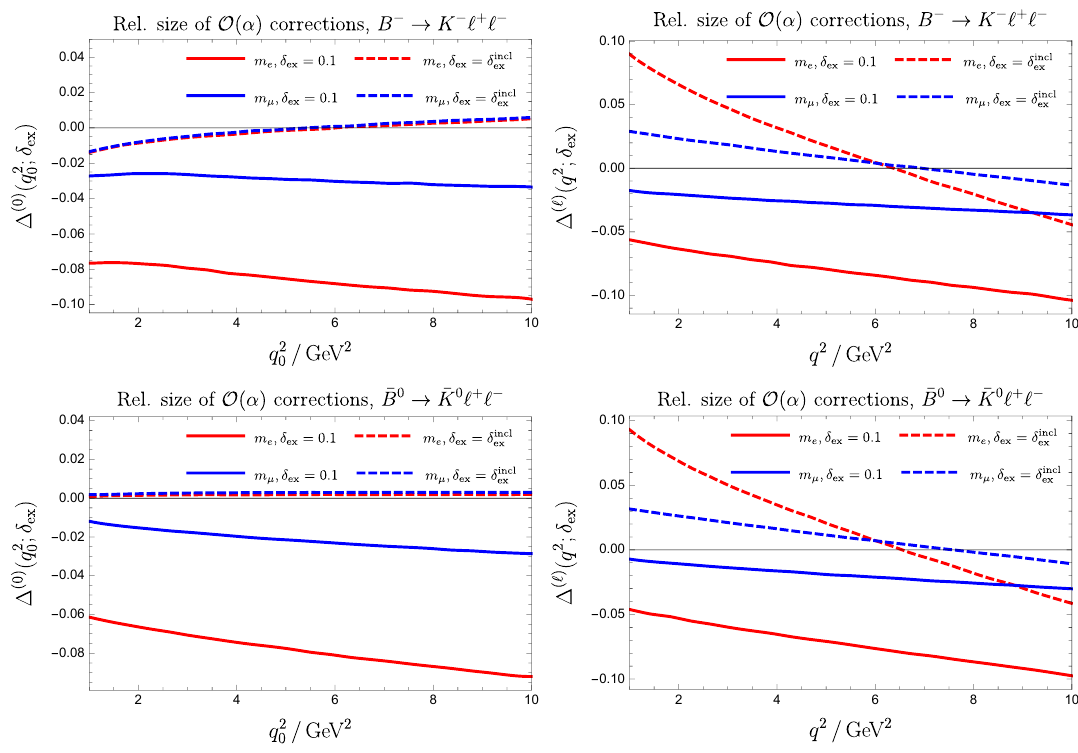
Figure 4 . Total relative QED-corrections, cf. (4.3) for the definition, including finite terms. The upper and lower figures correspond to the charged and neutral modes in the q 2 - and q 2 -variables 0 on the left and right respectively. In the photon-inclusive case ( δ ex = δ inc , dashed lines), all IR ex sensitive terms cancel in the q 2 variable locally and in the q 2 -variable when integrated which is 0 nicely visible in both cases. In the charged case, however, we see finite effects of the O (2%) due to ln ˆ m K “collinear logs” which do not cancel. An important aspect is the (approximate) lepton universality on the plots on the left. As is well-known, effects due to the photon energy cuts are sizeable since hard-collinear logs do not cancel in that case. This is in particular for